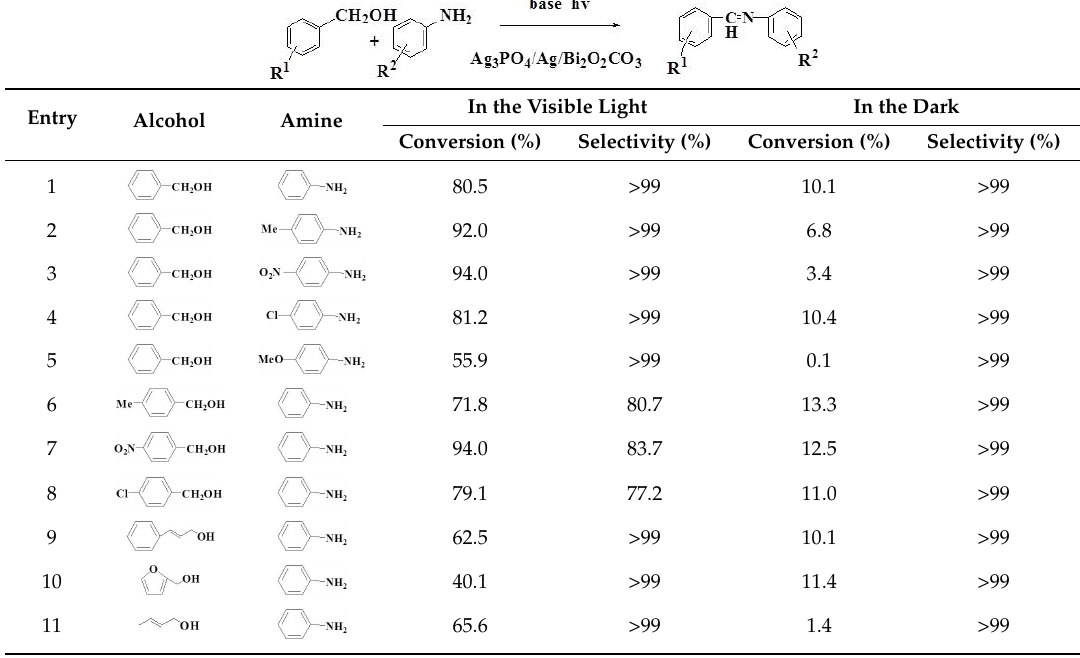
Synthesis of imines from benzyl alcohol and aniline substitutes using 71 wt % Table 3. Synthesis of esters from different alcohols using 71 wt% Ag 3 PO 4 /Ag/Bi 2 O 2 CO 3 . Table 3. Synthesis of esters from different alcohols using 71 wt% Ag 3 PO 4 /Ag/Bi 2 O 2 CO 3 . Table 3. Synthesis of esters from different alcohols using 71 wt% Ag 3 PO 4 /Ag/Bi 2 O 2 CO 3 . Table 3. Synthesis of esters from different alcohols using 71 wt% Ag 3 PO 4 /Ag/Bi 2 O 2 CO 3 . Table 3. Synthesis of esters from different alcohols using 71 wt% Ag 3 PO 4 /Ag/Bi 2 O 2 CO 3 . Table 3. Synthesis of esters from different alcohols using 71 wt% Ag 3 PO 4 /Ag/Bi 2 O 2 CO 3 . Table 3. Synthesis of esters from different alcohols using 71 wt% Ag 3 PO 4 /Ag/Bi 2 O 2 CO 3 . Table 3. Synthesis of esters from different alcohols using 71 wt% Ag 3 PO 4 /Ag/Bi 2 O 2 CO 3 . Table 3. Synthesis of esters from different alcohols using 71 wt% Ag 3 PO 4 /Ag/Bi 2 O 2 CO 3 . Table 3. Synthesis of esters from different alcohols using 71 wt% Ag 3 PO 4 /Ag/Bi 2 O 2 CO 3 .